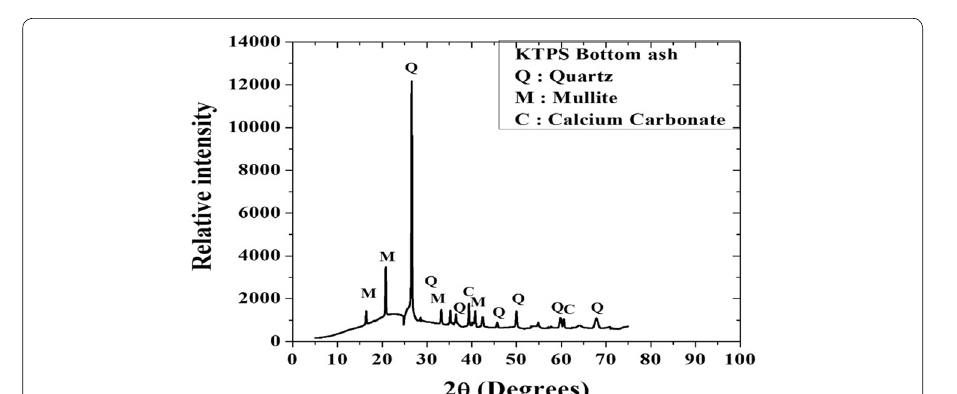
Fig. 5 X-ray diffraction pattern for KTPS Bottom ash sample